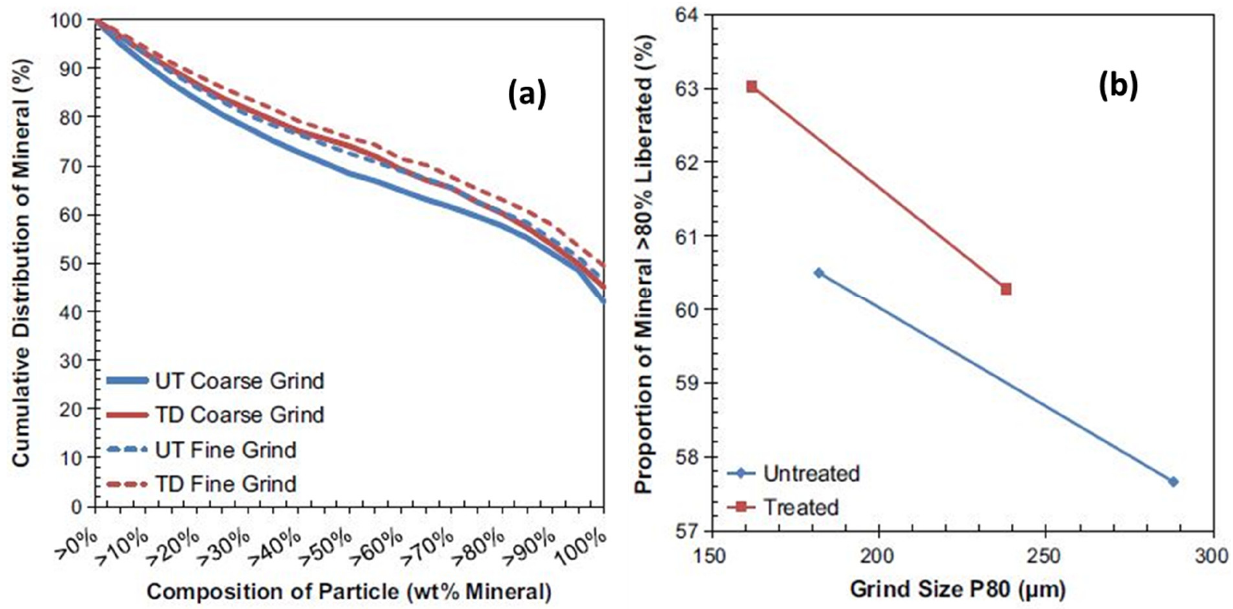
Figure 28. ( a ) Cumulative copper sulphide liberation by composition profiles, and ( b ) copper sulphide liberation versus grind size [160].